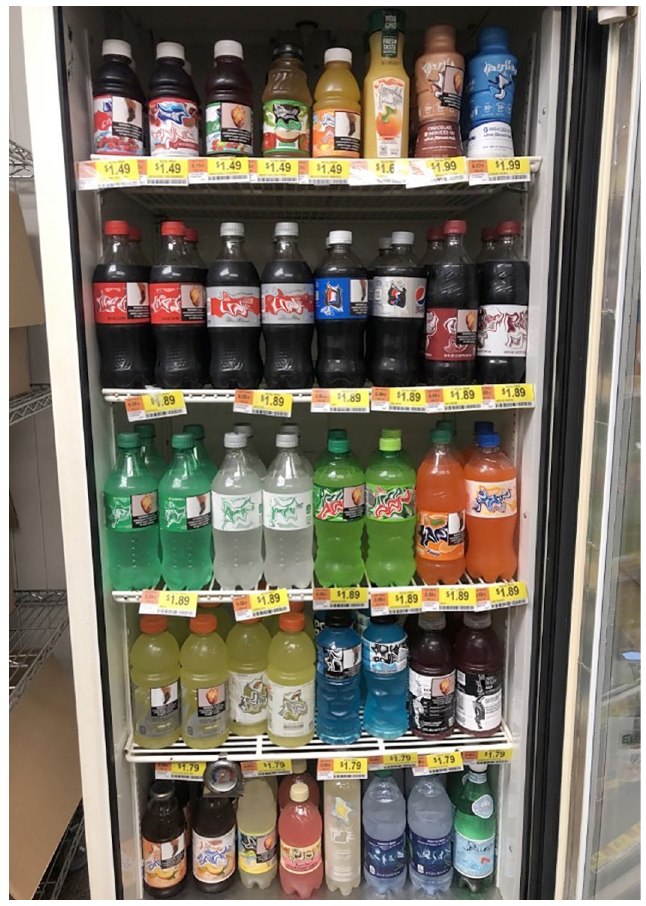
Fig 2. Photographs of UNC Mini Mart during a trial evaluating graphic health warnings for sugary